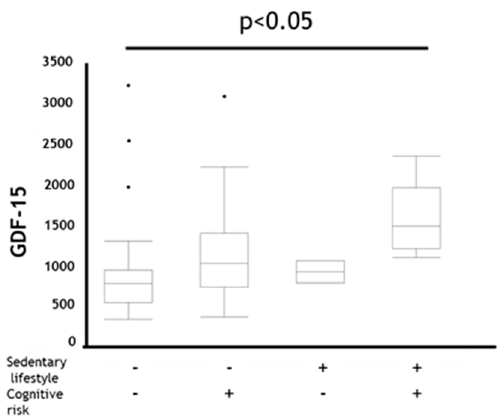
Figure 1. Comparison of GDF-15 in coexistence status with sedentary lifestyle and cognitive risk in all subjects. Data are presented as box plot including median (IQR). P -values compared among subjects by Kruskal–Wallis test. GDF-15: Growth Differentiation Factor-15, Sedentary lifestyle + : EX (MET × hours per day) < 1.5, Sedentary lifestyle − : EX (MET × hours per day) ≥ 1.5, Cognitive risk + : MoCA-J scores ≤ 25, Cognitive risk − : MoCA-J scores > 25. Table 4. Diagnostic ability in age and GDF-15 to identify motoric cognitive risk (MCR) in all subjects. AUC Sensitivity